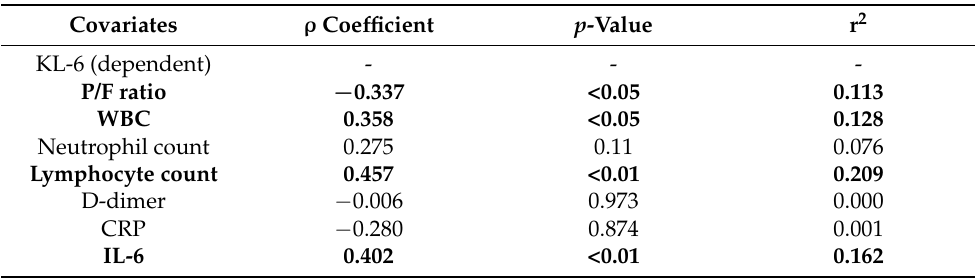
Table 4. Correlation and regression analysis of laboratory parameters among the enrolled patients, regardless of the time of observation. Covariates ρ Coefficient